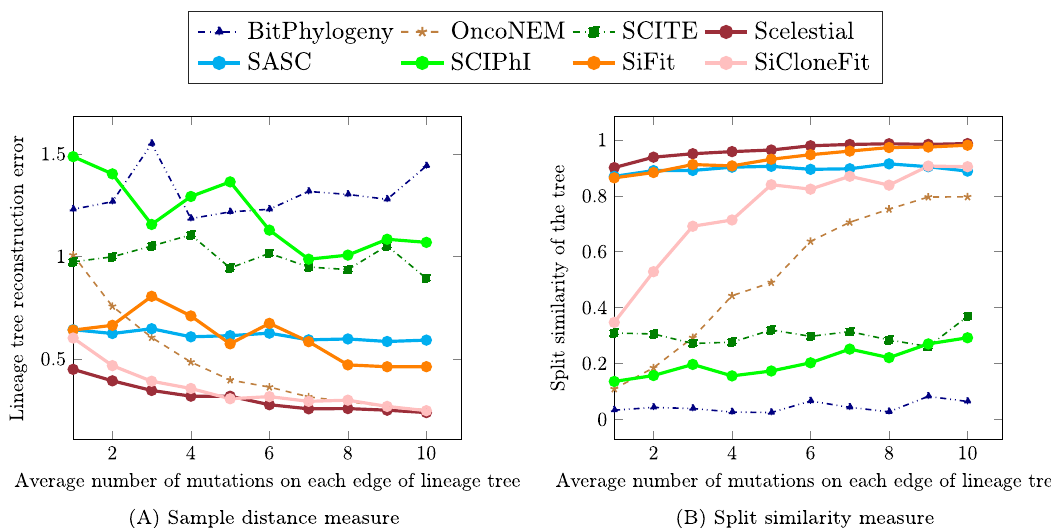
Fig 2. Comparison of the methods for single-cell lineage tree reconstruction on simulated tumor data. Note that in case of the lineage tree reconstruction error (A), lower values show a better reconstruction. On the other hand, the split similarity measure represents (B) similarity between the reconstructed tree and the ground truth tree, making higher values